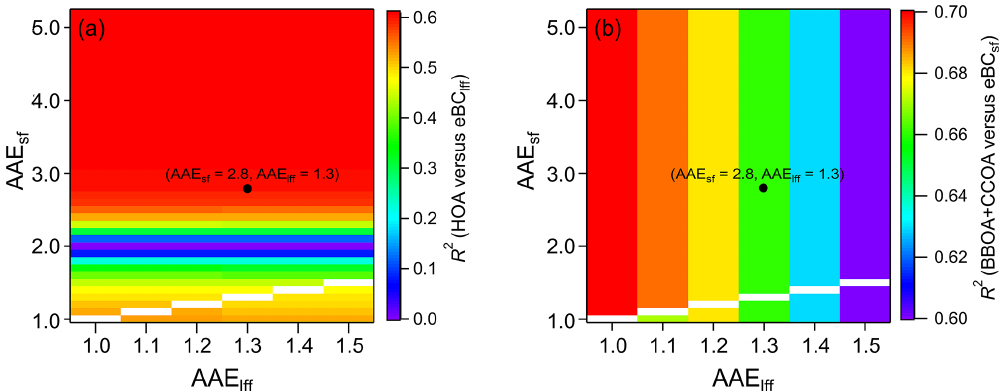
Figure 2. Distributions of the coefficient of determination ( R 2 ) of (a) hydrocarbon-like organic aerosol (HOA) versus equivalent black carbon (eBC) from sources of liquid fossil fuels (eBC lff ) and (b) the sum of the mass concentrations of biomass burning and coal combustion organic aerosols (BBOA + CCOA) versus eBC from sources of solid fuels (eBC sf ) at different absorption Ångström exponents of liquid fossil fuels (AAE lff ) and solid fuels (AAE sf ).